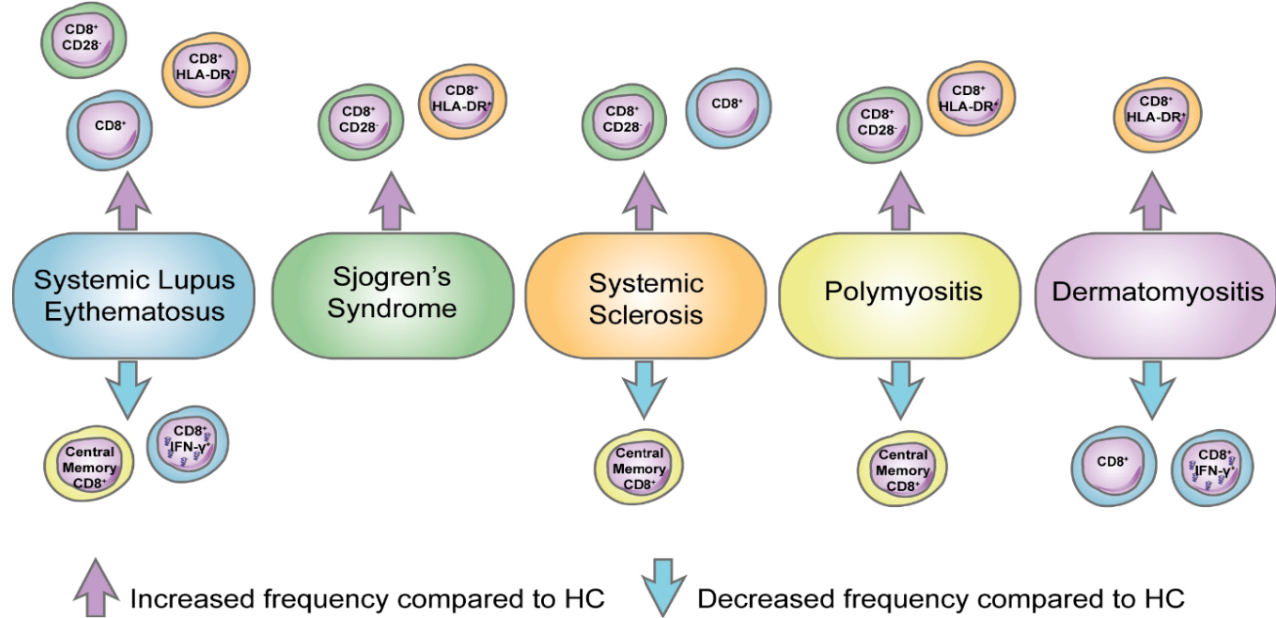
Figure 2. Shared aberrations in peripheral blood CD8 + T cell population frequencies across adult CTDs compared to HC. In DM, frequencies of total CD8 + T cells as well as CD8 + T cells expressing intracellular IFN- γ were only diminished in patients with active disease.